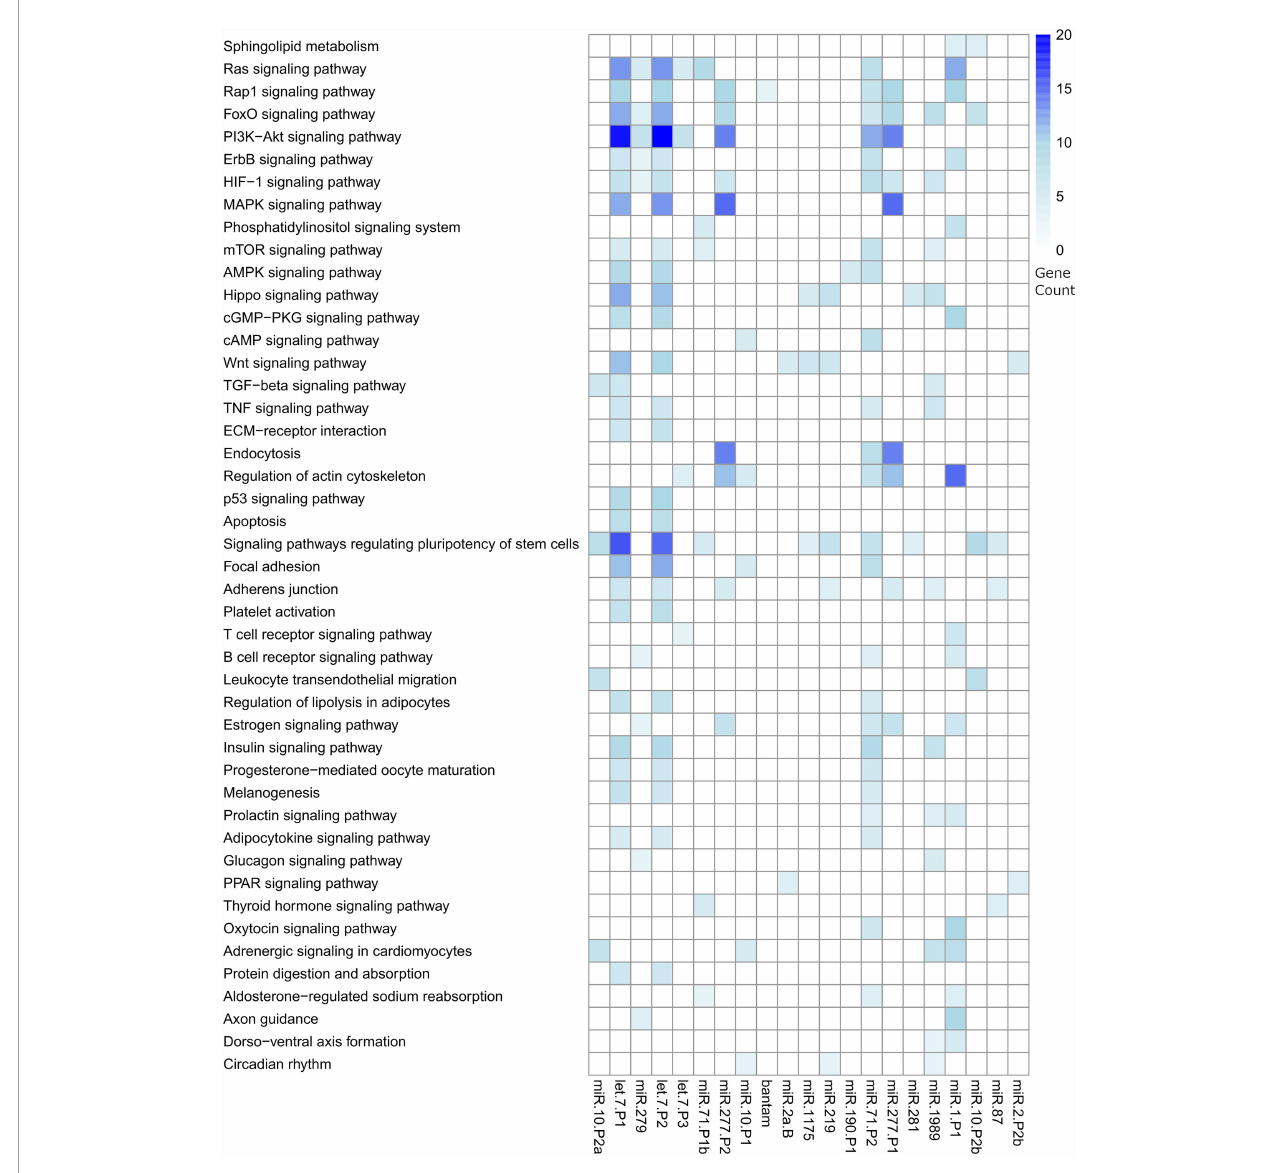
FIGURE 5 | Heatmap showing the signi fi cant pathways regulated by the miRNAs contained in the EVs of F. hepatica . DAVID database was used to calculate enriched pathways. Counts of genes targeted within each pathway are indicated by a color scale. The list of targeted transcripts is reported in Table S6 and those related to immunity are presented in Table S7